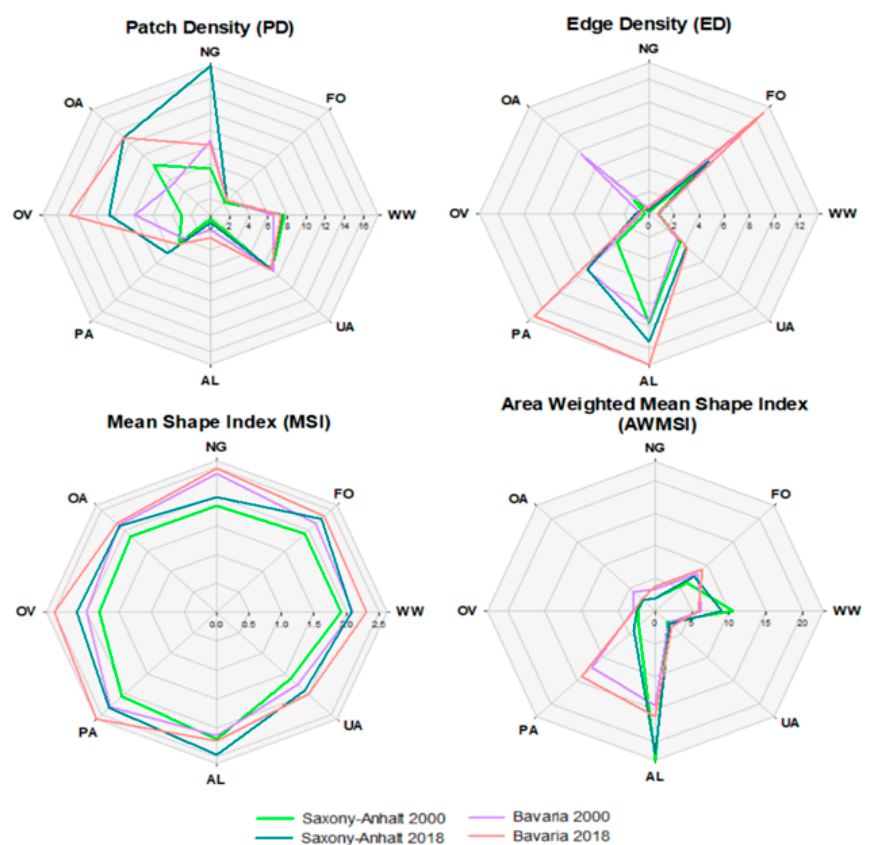
Figure 5. Landscapematrixevaluation. Note: Figure 5. Landscape matrix evaluation. Note: the value of PD was multiplied by 1000 to facilitate visualization.